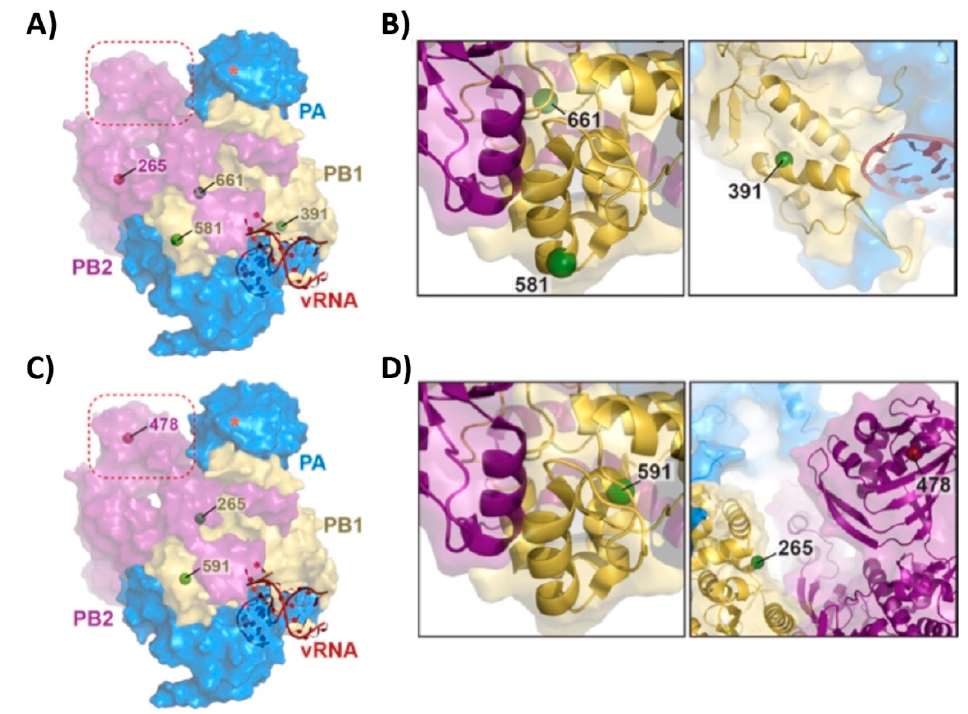
Figure 9. Location of the ts, ca and att mutations of AA and Len MDV in the viral polymerase complex. ( A ) PB1 (green spheres) and PB2 (purple sphere) mutations responsible for the ts, ca and att phenotype of AA are shown on the reference model of the RNA dependent RNA polymerase, RdRp, complex (PDB ID 5M3H) [58]. The RdRp complex is shown as a surface-rendering model with its subunits PA (blue), PB1 (yellow) and PB2 (purple), and bound vRNA (red). Dotted square (red) indicates the PB2 cap-binding domain. Red asterisk shows the approximate location of the endonuclease catalytic site of PA. ( B ) Close-up images of the locations of the AA PB1 mutations E581G and A661T (left) and K391E (right). ( C ) Same as in ( A ) but for Len. ( D ) Close up locations of LenV591I (PB1, left), K265N (PB1, right) and V478L (PB2, right) mutations. All images were generated and rendered in the program Pymol [59].